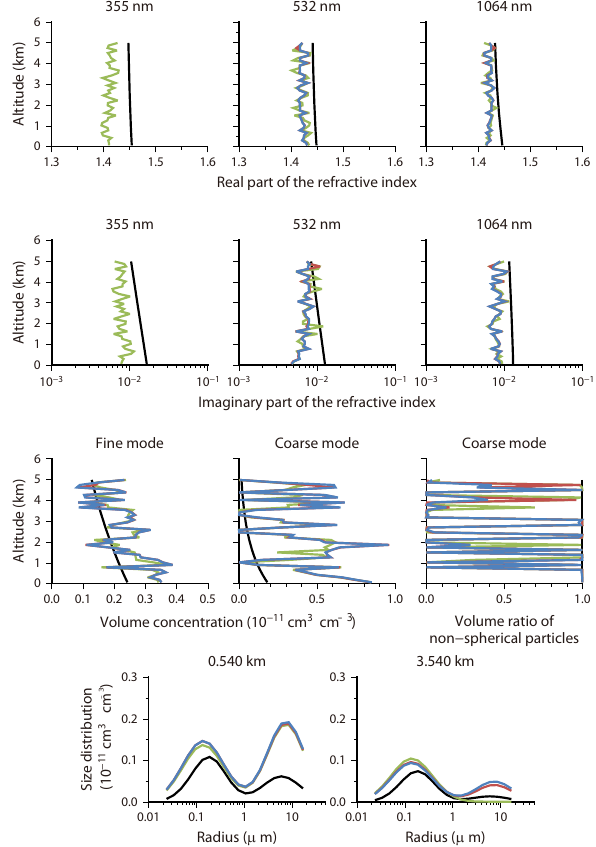
Figure 6. Same as Fig. 4 but showing the retrieval results from the simulated data with random errors for the continental average aerosol. Note that the ranges of the horizontal axes in the plots of the volume concentration of the coarse mode and the volume ratio of the non-spherical particles to total particles in the coarse mode are different from those in Fig. 4.